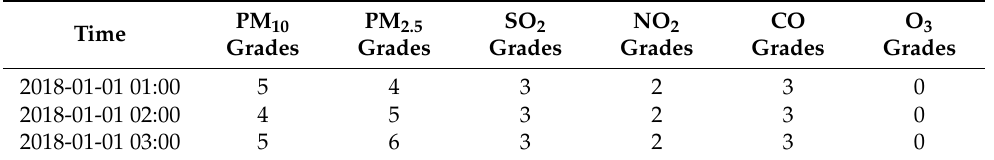
Table 5. An example of air pollutant grades at the Central Square Station of the Xi’an Xin Cheng district in Xi’an city from 2018 to 2020 after redivision